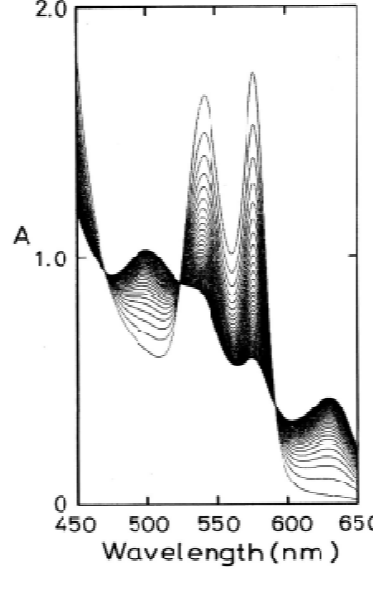
Figure 1. Spectral changes over time from 450 nm to 650 nm following human HbO autoxidation, redrawn from Sugawara et al . [16]. The changes were monitored in 0.1